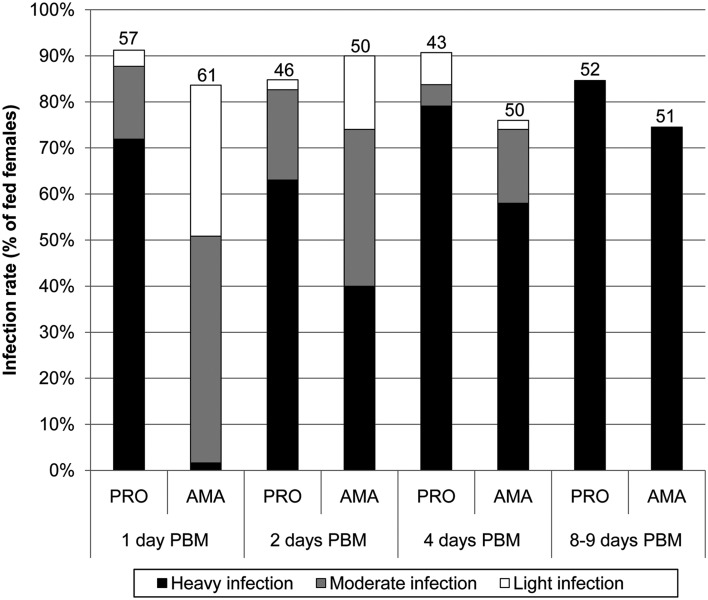
Infection rates (percent of females infected) and intensities of L. donovani infections in P. argentipes. Parasite load was estimated by fluorescent microscopy: light infections, <100 parasites per gut; moderate infections, 100–500 parasites per gut; heavy infections, >500 parasites per gut. Numbers of dissected females are shown above bars. PRO, promastigote-initiated infections; AMA, amastigote-initiated infections; PBM, post bloodmeal. Differences between groups were evaluated using Chi-square test: day 1 PBM, P < 0·0001, χ2 = 65·737, d.f. = 3; day 2 PBM, P = 0·021, χ2 = 9·743, d.f. = 3; day 4 PBM, P = 0·036, χ2 = 8·518, d.f. = 3; days 8–9 PBM, P = 0·203, χ2 = 1·6202, d.f. = 1.